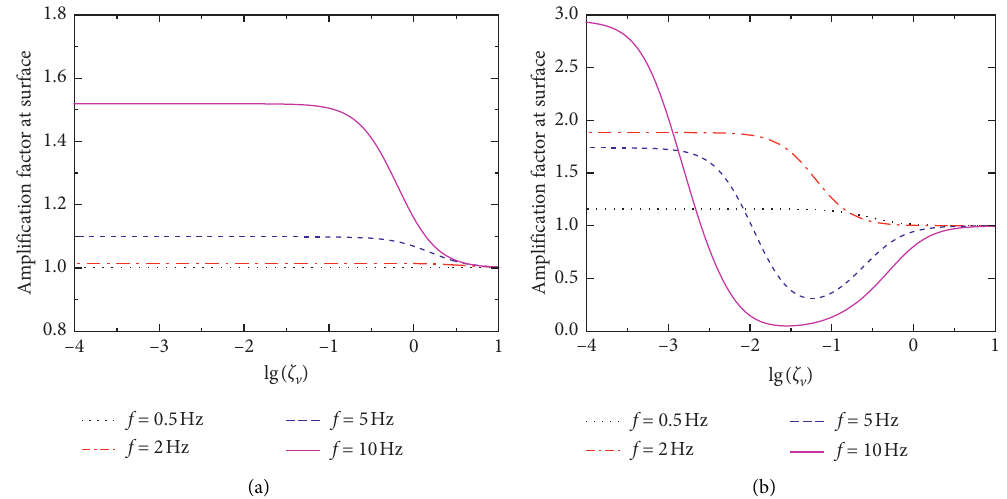
Figure 10: Variation of amplification factor at surface with damping coefficient ξ